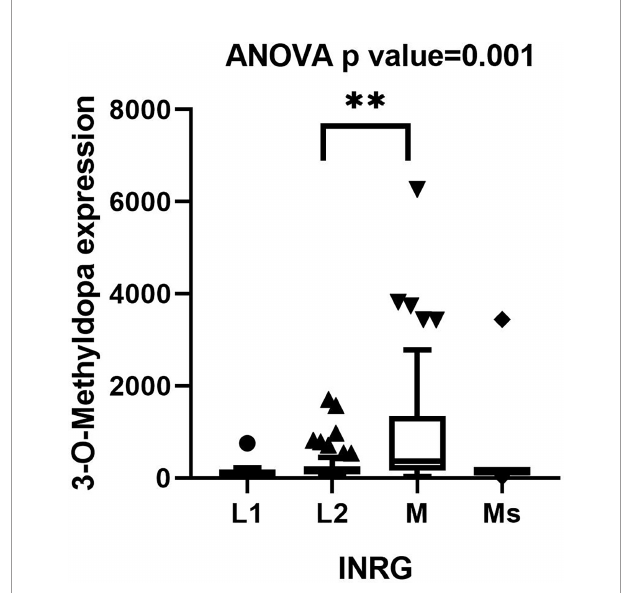
FIGURE 3 | Boxplot displaying the distribution of 3-O-Methyldopa expression in 122 NB patients grouped by INRG stage. Boxplot was visualized using Tukey ’ s method. Signi fi cance of the expression differences of 3-O-Methyldopa across INRG stages was assessed by one-way ANOVA test. P value is reported on top of the panel. Post-hoc analysis comparing 3-O- Methyldopa expression between every possible pair of INSS stages was performed by Tukey ’ s multiple comparisons test. Signi fi cant pairs were indicated by brackets and asterisks. ** indicates p value lower than 0.005.